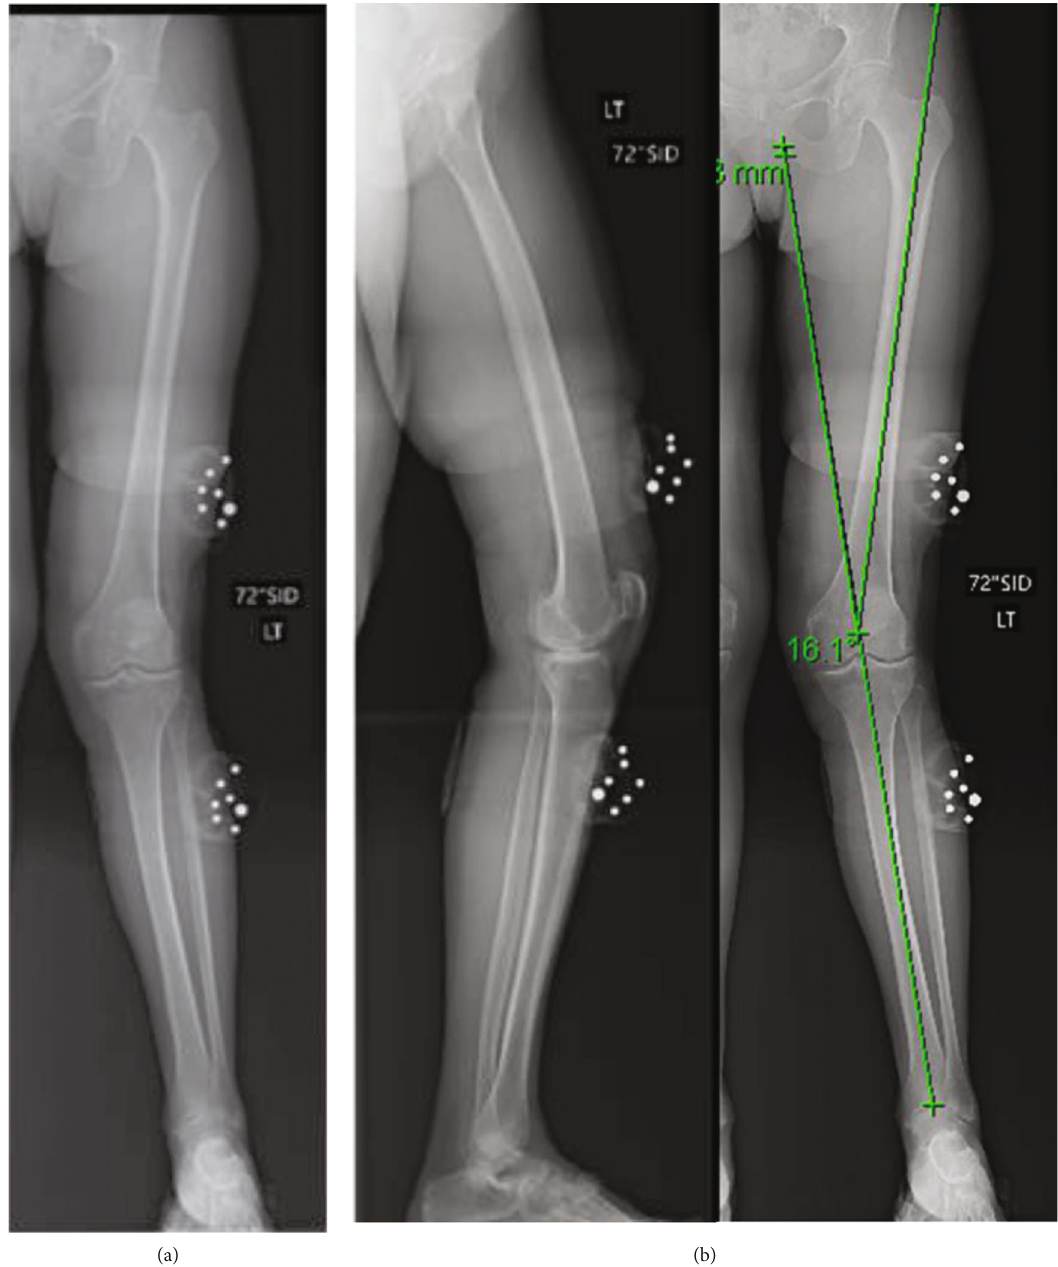
Figure 20: Preoperative long-leg (a) AP and (b) lateral X-rays showing Kellgren-Lawrence grade 3 changes and a rigid fl exion contracture for Case 5. A valgus alignment in extension of 16.1 degrees, also including the markers of ROSA rigid body trackers used for preoperative 2D – 3D imaging